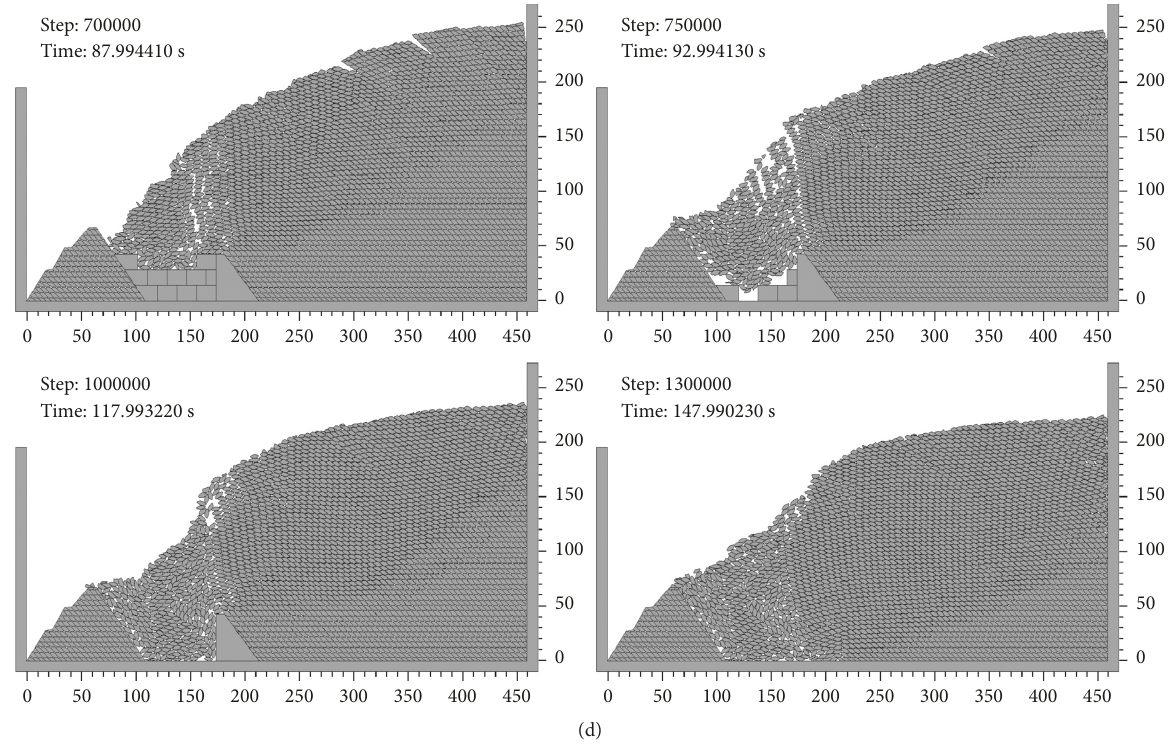
Figure 16: Slope instability of the four mining scenarios. (a) Scenario 1. (b) Scenario 2. (c) Scenario 3. (d) Scenario